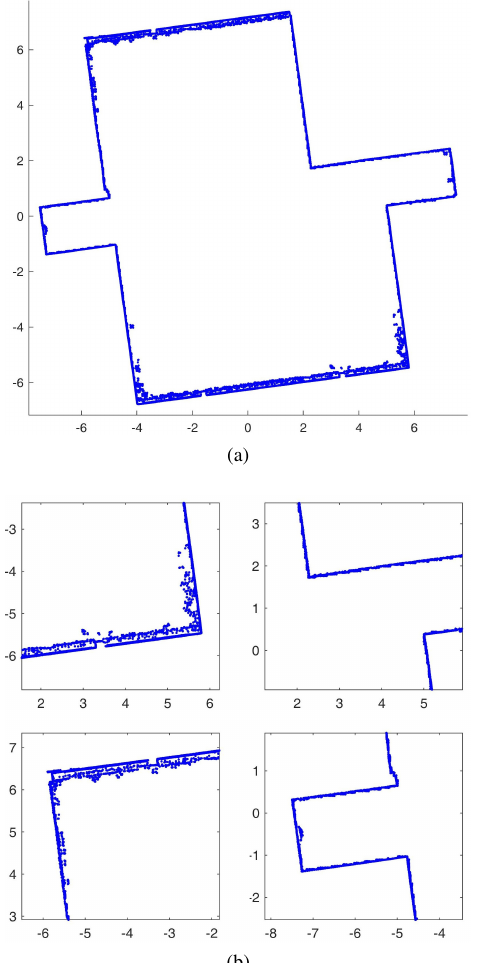
Figure 7: Final reduced point cloud: (a) overview, (b) details.